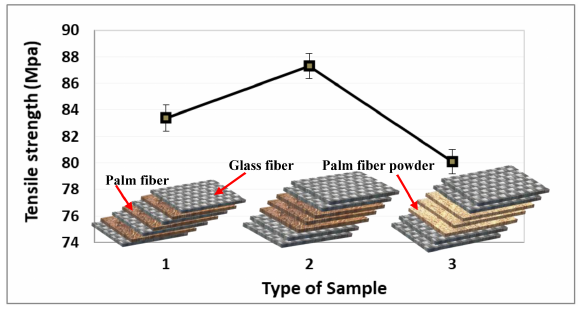
Fig. 6. The effect of fiber layers (order and form) on the tensile strength.